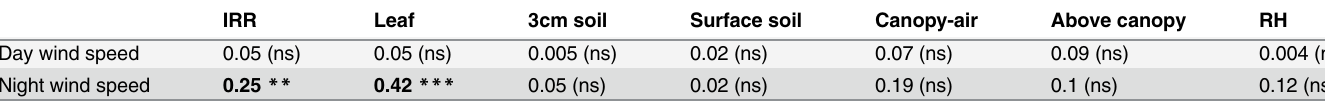
Table 2. The relationship of wind speed with microclimate temperature at the PHACE experiment.